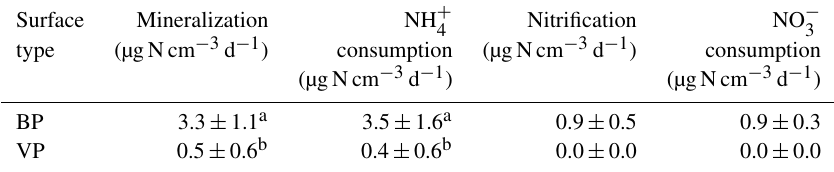
Table 2. Gross N transformation rates from bare peat (BP) and vegetated peat (VP) calculated from mineral-N pools in the soil.